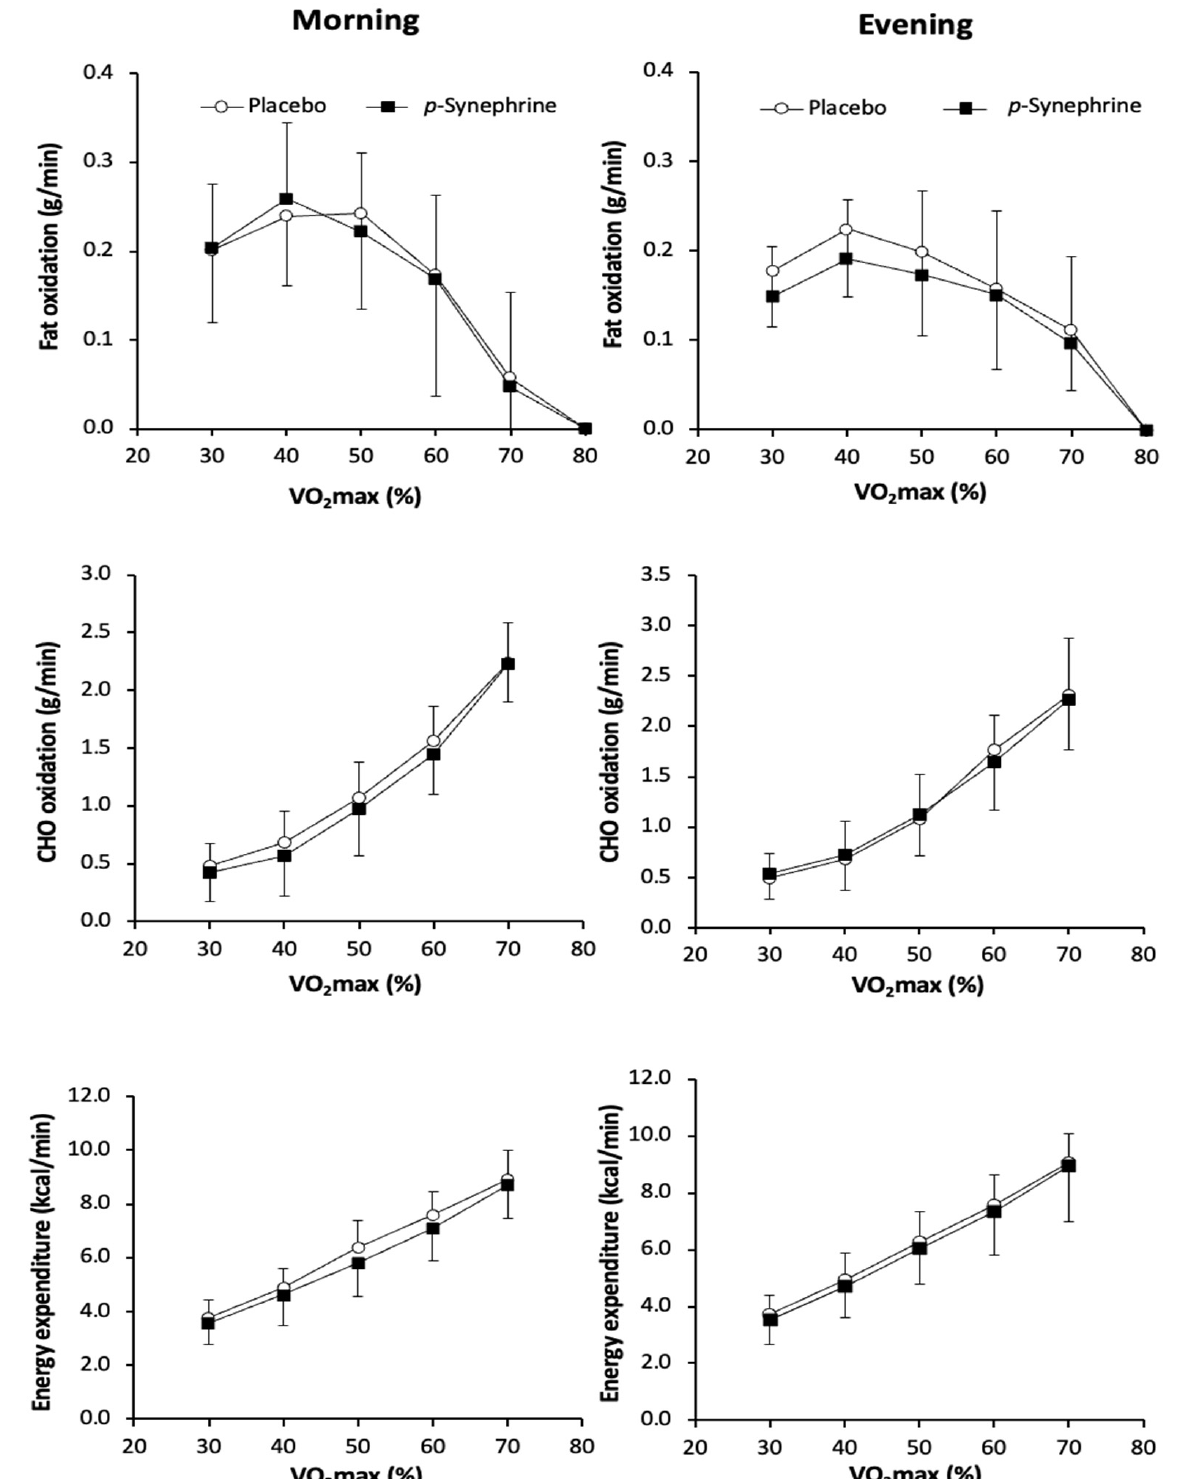
Figure 2. Rates of fat oxidation (in g/min), carbohydrate oxidation (in g/min) and energy expenditure (in kcal/min) during exercise of increasing intensity performed in the morning (8:00–10:00 h) or the evening (17:00–19:00 h) after the ingestion of 3 mg/kg of p -synephrine or a placebo in women.